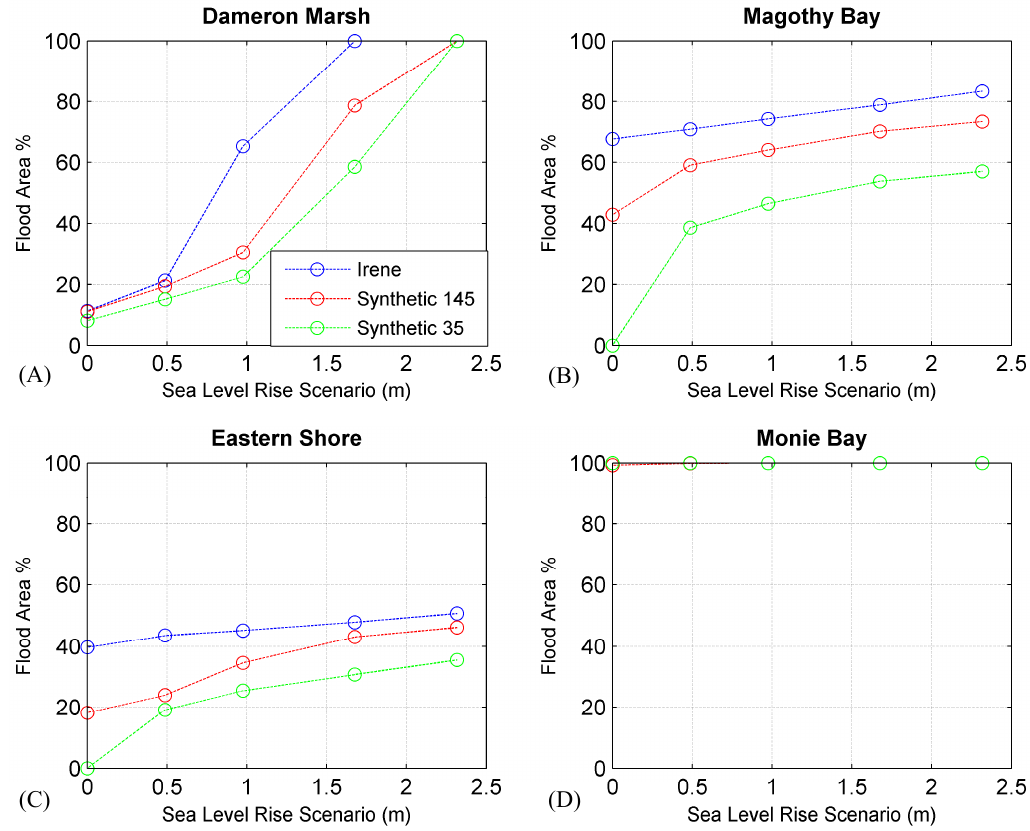
Figure 4. Percent of inundated area at each preserve areas for current condition and different SLR scenarios. The top panel shows the percent of inundated area for ( A ) Dameron Marsh and ( B ) Magothy Bay. In the bottom panel results are shown for ( C ) Eastern Shore and ( D ) Monie Bay Preserve Area.